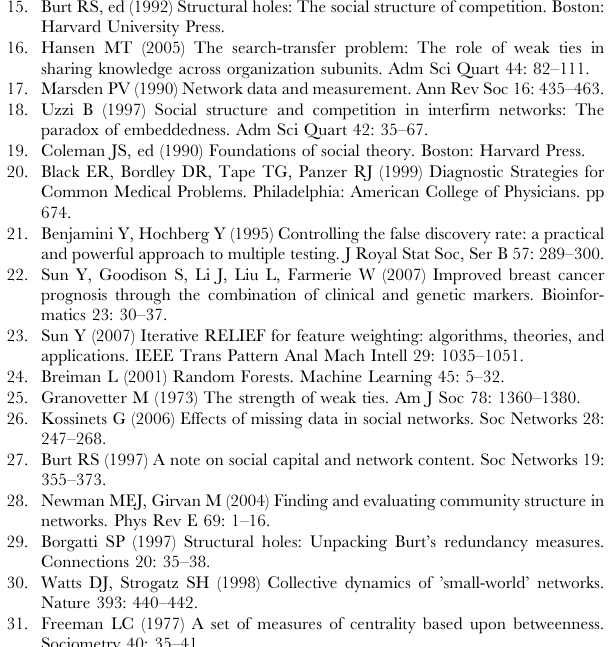
we repeated the procedure for adding self-reported ties, if chosen persons shared at least a certain number of common contacts. Table S1 We show Pearson’s correlations between a person’s self-reported and email derived network characteristics for the 31 partners in the same office, utilizing total volume (VM), reciprocation (RM) and normalization method (NM). Table S2 We show Pearson’s correlations between a person’s self-reported and email derived network characteristics for the 31 partners in the same office, utilizing the randomized total volume (rVM), reciprocation (rRM) and normalization method (rNM).